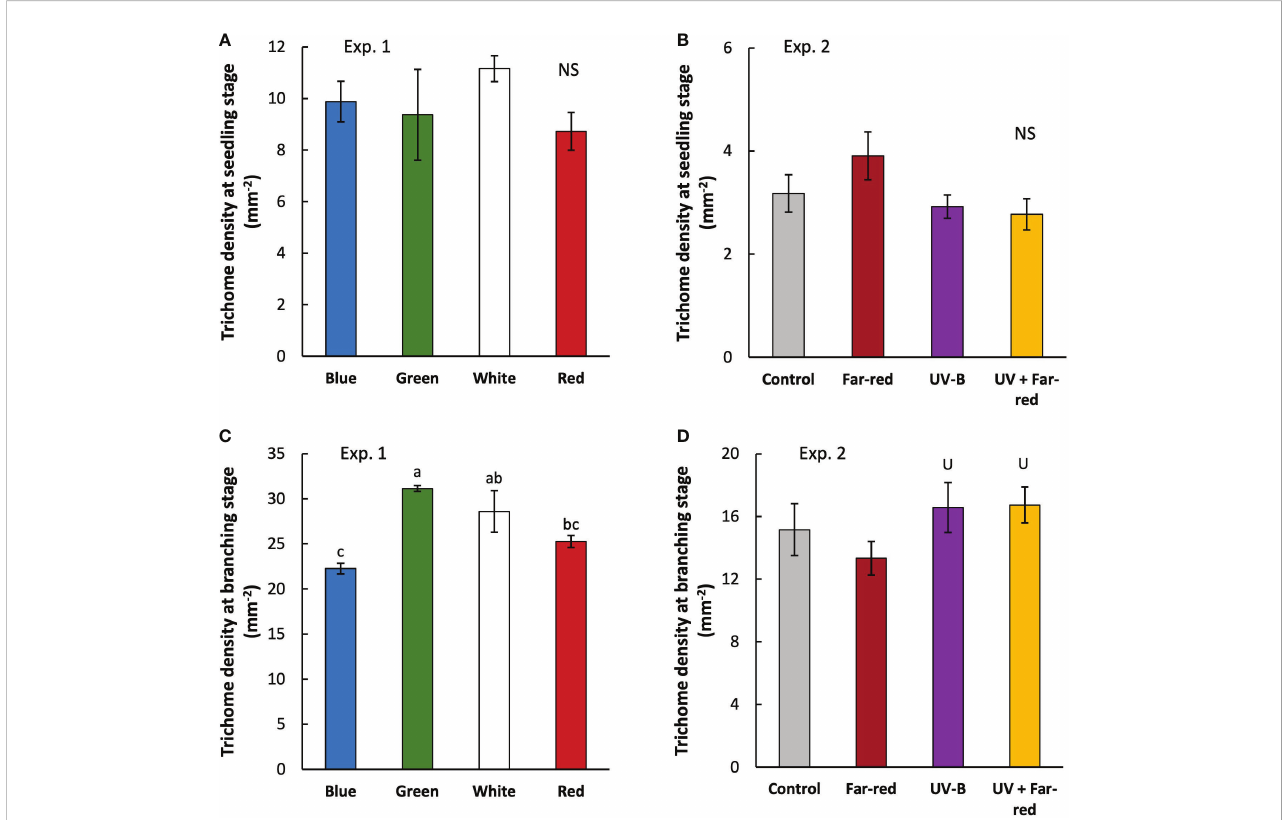
FIGURE 5 Trichome density measured at three weeks (seedling stage; (A, B) and fi ve weeks (branching state; (C, D) after transplanting in treatments with supplemental radiation within (A, C; Exp. 1) and outside (B, D; Exp. 2) PAR wavelength range (values are mean ± s.e.; n = 4, with three plants in each statistical replicate). Details on the treatment abbreviations can be found in Figure 1. “ NS ” in panel A and B indicates non-signi fi cant treatment effects. Different letters in panel C indicate signi fi cant differences between treatments ( p < 0.05; ANOVA test was done using log transformed data). “ U ” in panel D indicates signi fi cant effects from supplemental UV-B ( p <